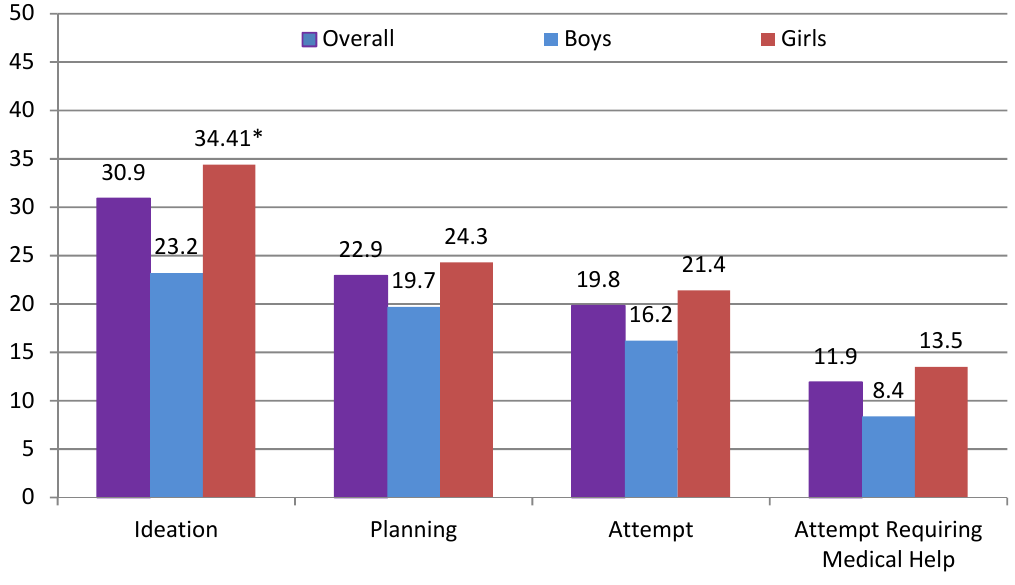
Figure 1. Prevalence of suicidal ideation and suicidal behaviors for boys and girls living in the slums of Kampala ( N = 457). * Girls were more likely than boys to report